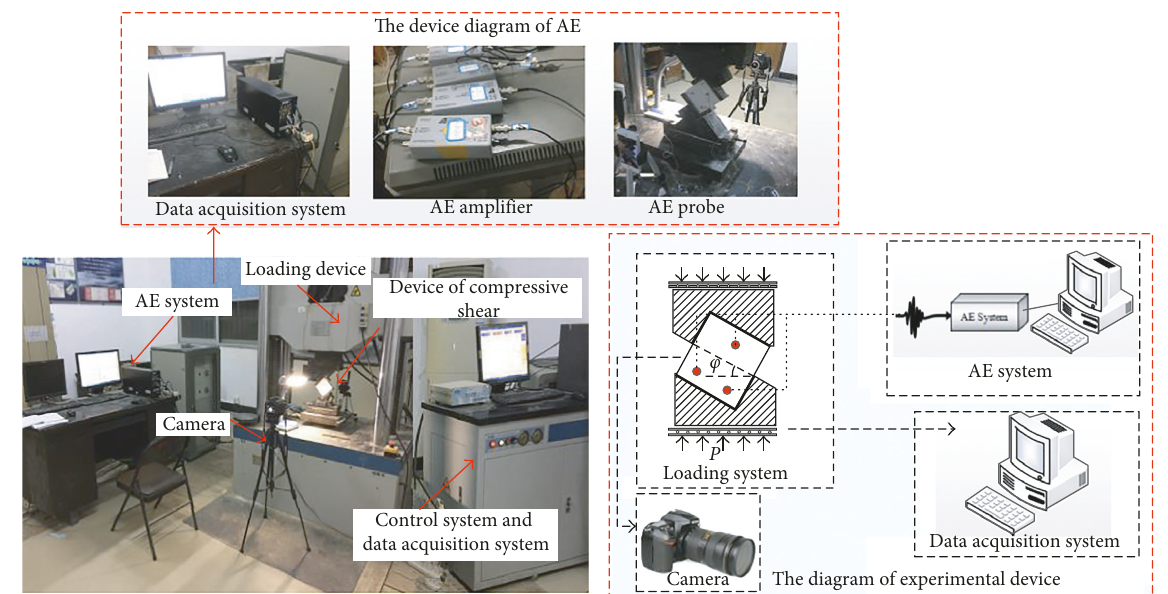
Figure 2: The device of the field test and schematic diagram.